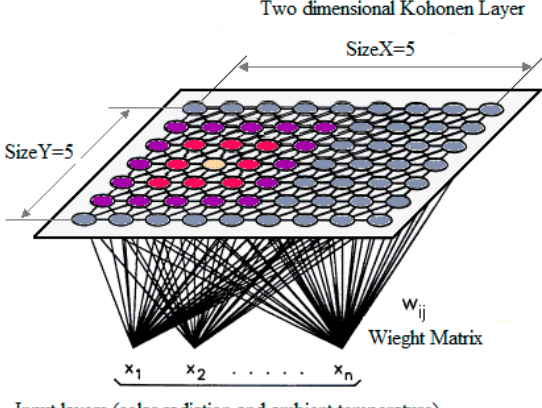
Figure 6. The self-organizing feature map (SOFM) architecture.